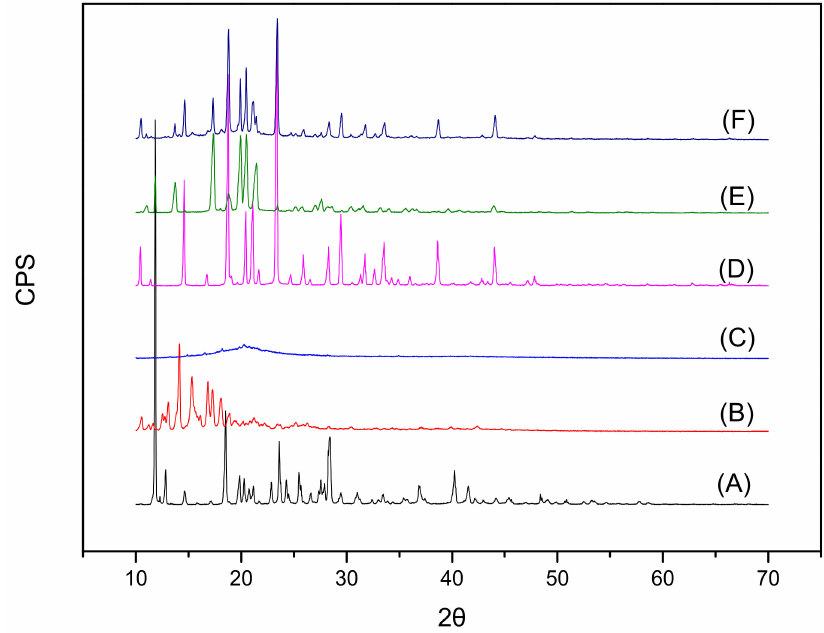
Figure 4. X-ray diffraction spectra: (A) paeonol; (B) CHO; (C) SPC; (D) mannitol; (E) the physical mixture; (F) PAE ethosome freeze-dried powder.